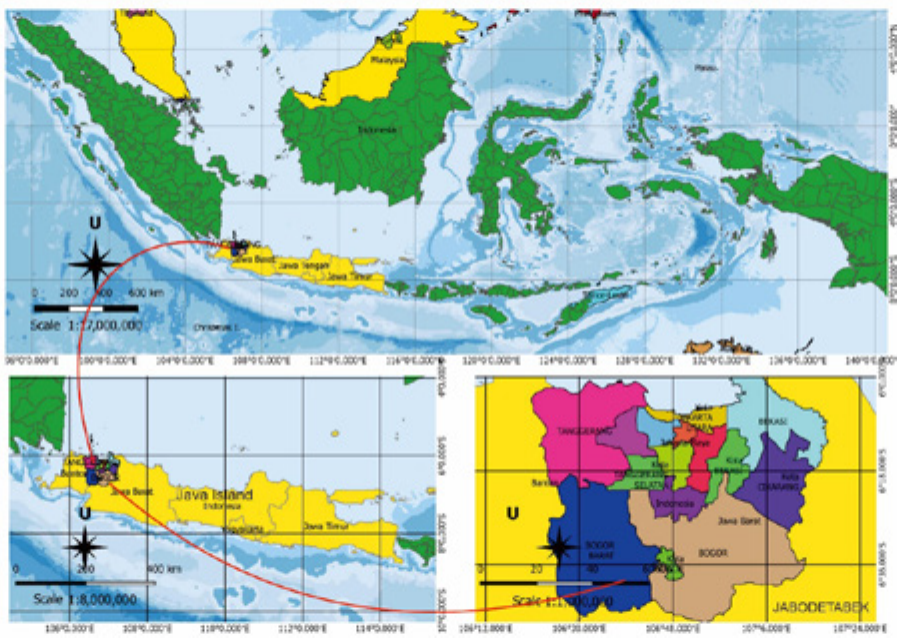
Fig. 1: Geographic location of the study area in Indonesia, Java Island and Fig. 1 : Geographic l ocation of the study area in Indonesia, Java Island and Jabodetabek